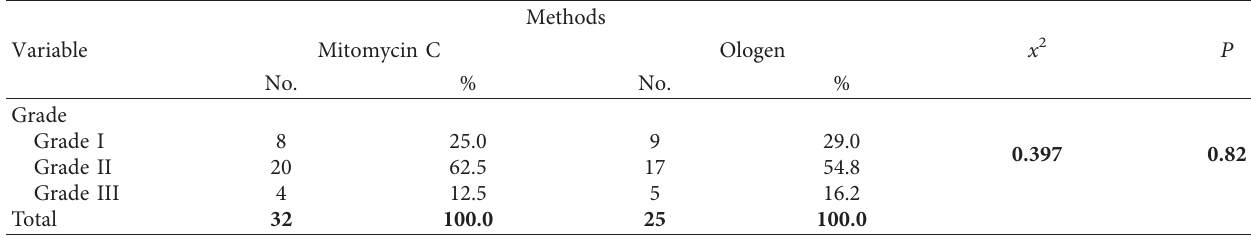
Table 2: Distribution of the clinical grades of pterygia in both groups.